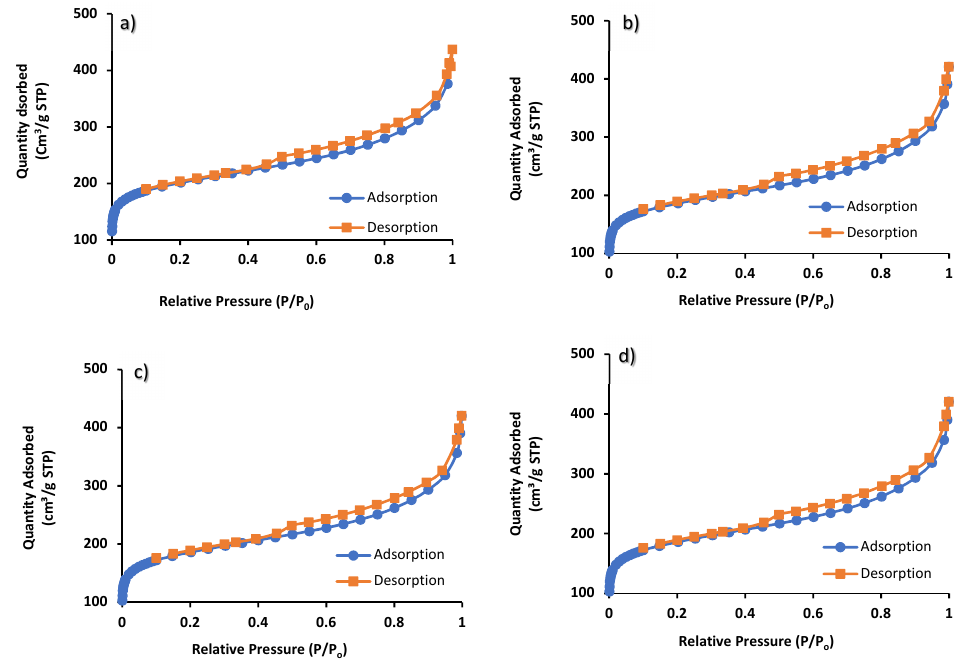
Figure 5. N 2 adsorption-desorption isotherms of synthesized AC-Pd1 ( a ), AC-Pd2 ( b ), AC-Pt1 ( c ), and AC-Pt2 ( d ) composites.